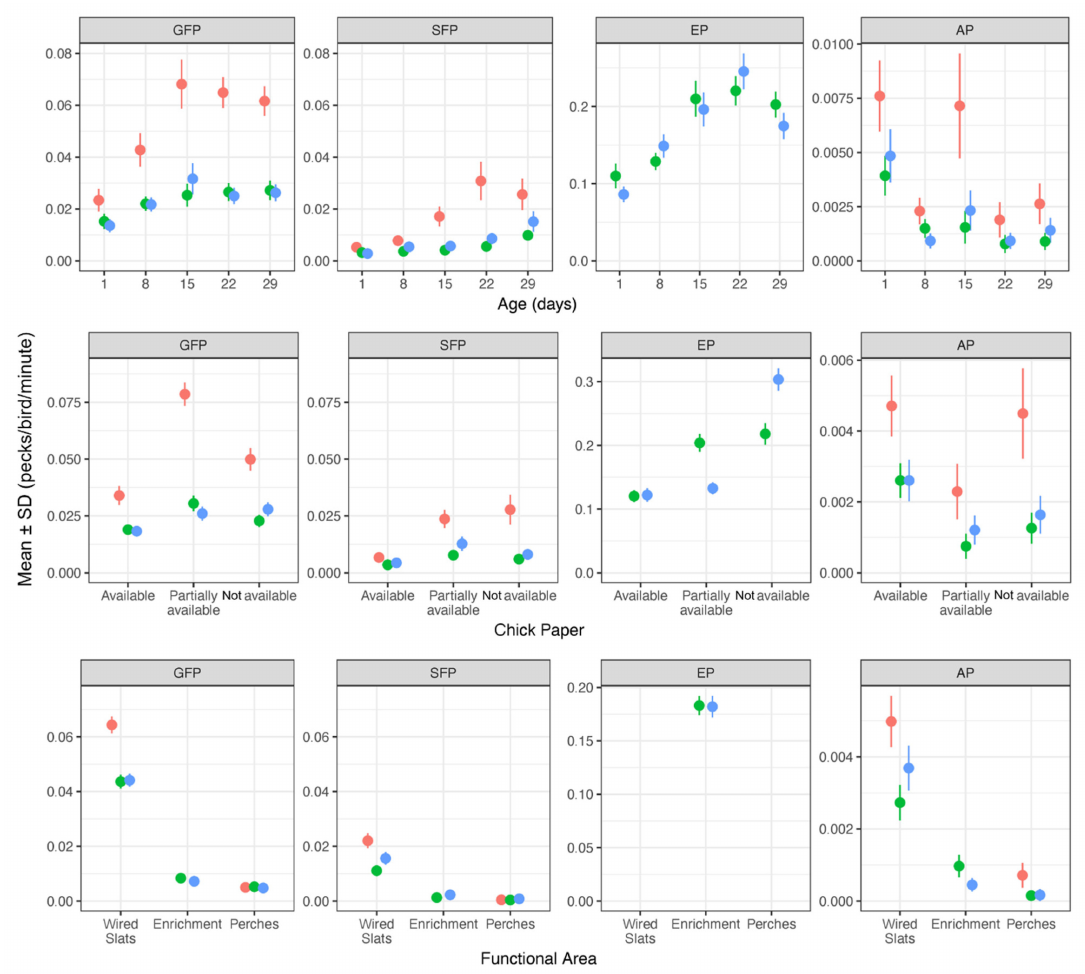
Figure 1. Descriptive analysis (mean +/– SD pecking pecks/bird/min) of the occurrence of gentle feather pecking (GFP), severe feather pecking (SFP), enrichment pecking (EP), and aggressive pecking (AP) in the experimental groups. Red = NE (not enriched, high stocking rate), green = EL (enriched, low stocking rate), blue = HE (enriched, high stocking rate). Upper row: pecking behavior on the five observation days (days of life 1, 8, 15 22, and 29), middle row: pecking behavior depending on the availability of chick paper, lower row: pecking behavior in the different functional areas. Behavior was observed in eight compartments per experimental group (NE, EL and EH) in both rearing periods with two cameras per compartment. On days of life 1 and 8 we analyzed 15 min and on the remaining days (15, 22 and 29) 9 min per day and